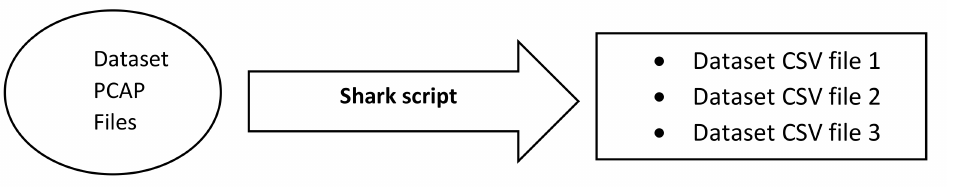
Figure 3. Feature